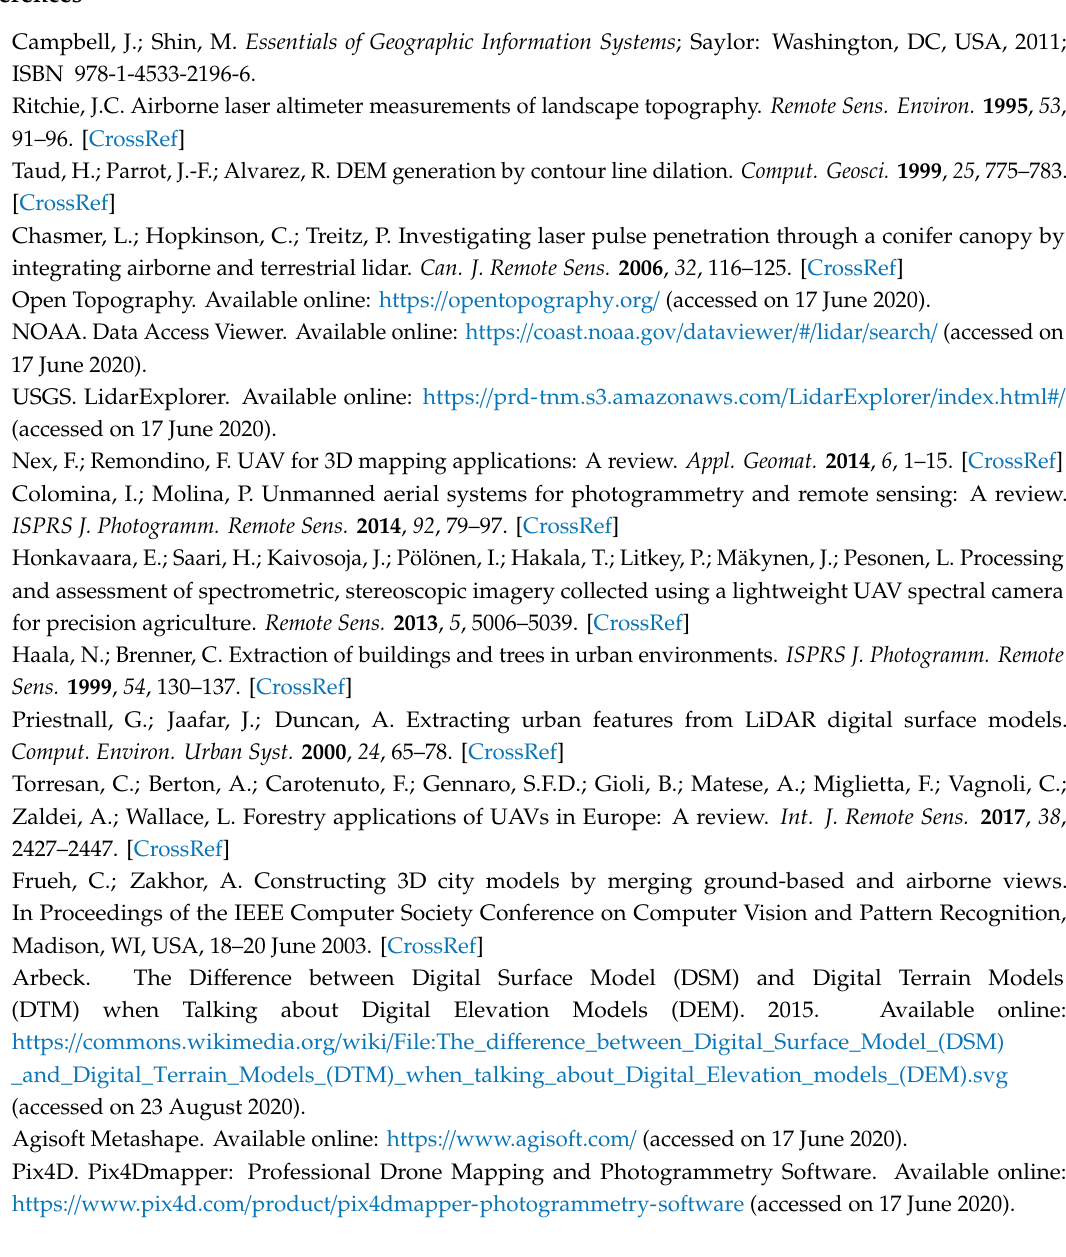
Table S1: Locations of checkpoints (CP) in decimal degrees, altitude (m) of each checkpoint, and di ff erences between respective DSMs and checkpoints in meters (m) listed by platform: LiDAR, INS (Inspire), MAT (Matrice), MAV (Mavic Pro), P4P (Phantom 4 Pro). Overall Mean Error (ME), Standard Deviation of Error (St. Dev.), Mean Average Error (MAE), and RMSE also